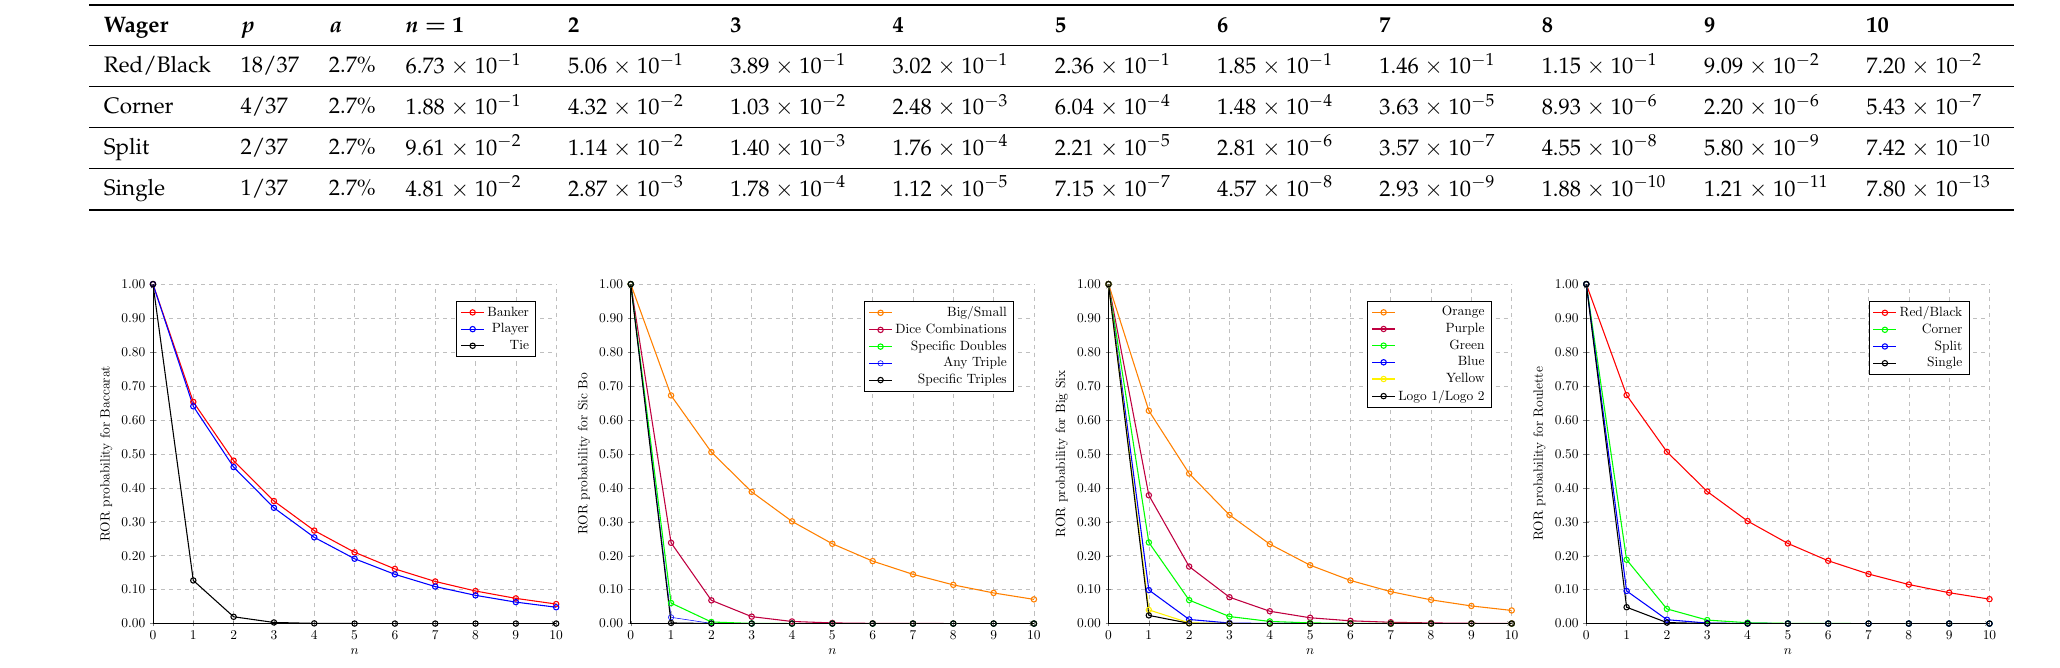
Figure 1. The ROR probability of various gambling methods predicted by the proposed